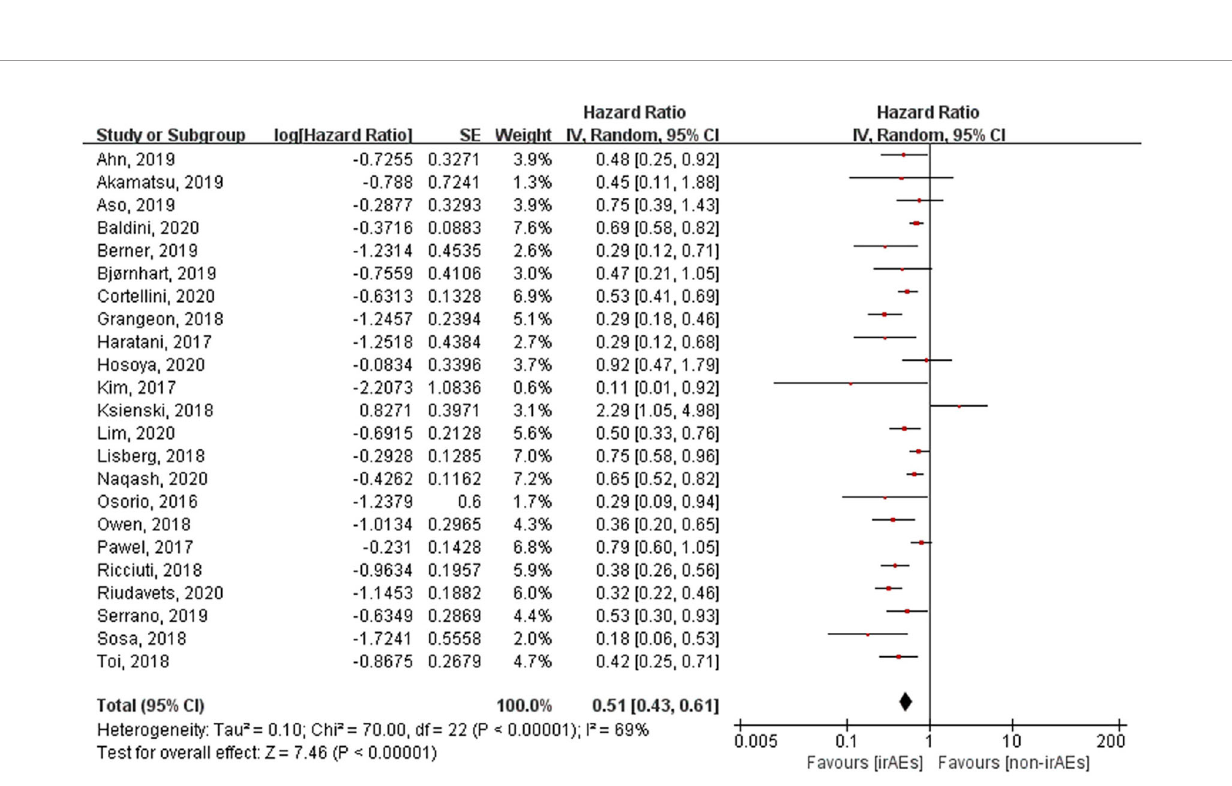
FIGURE 3 | Forest plot of the association between the occurrence of irAEs and OS. OS, overall survival; irAEs, immune-related adverse events; non-irAEs, non- immune-related adverse events.